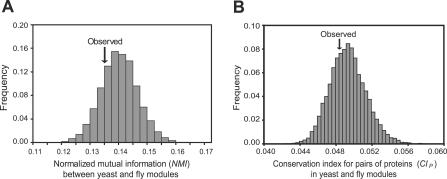
Lack of Evolutionary Conservation between the Yeast and Fruit Fly PPI Modules(A) The observed NMI between yeast and fruit fly modules is not significantly different from chance expectation. The bars show the distribution of NMI between yeast and fly modules when the yeast modules are randomly separated.(B) The observed CIP (conservation index for pairs of proteins) between yeast and fruit fly modules is not significantly different from chance expectation. The bars show the distribution of CIP between yeast and fly modules when the yeast modules are randomly separated.